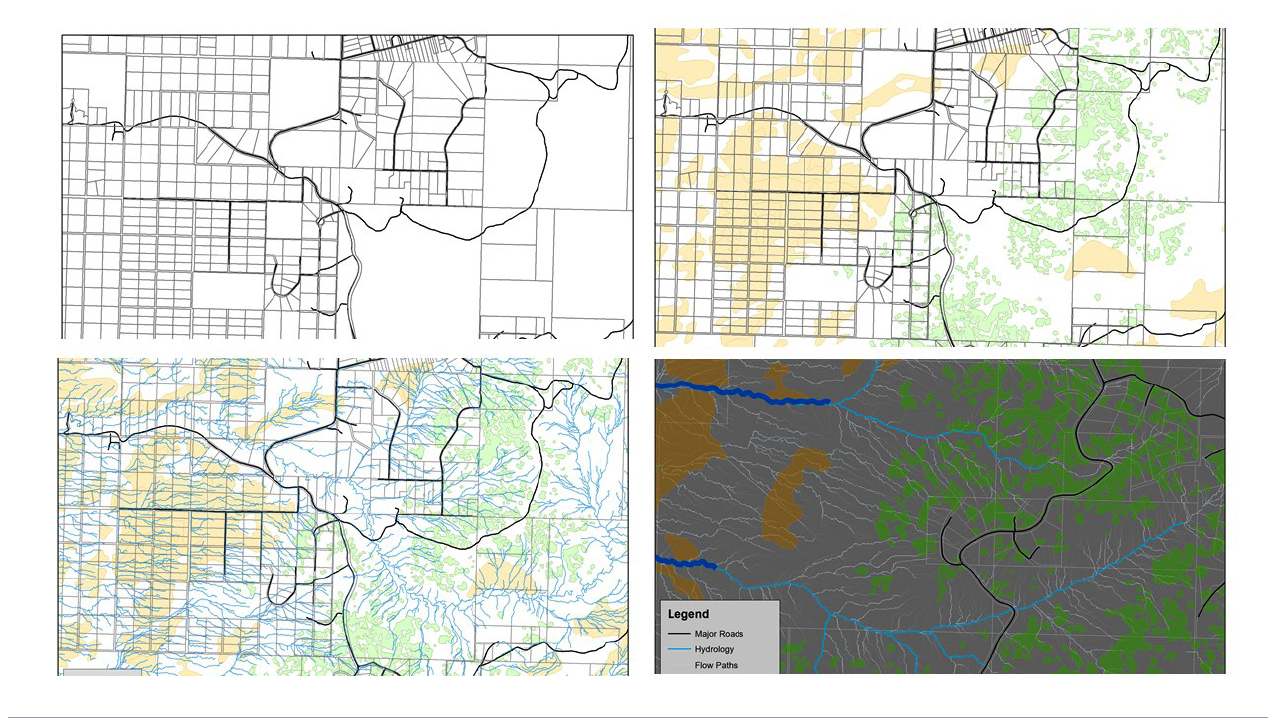
Fig. 4. Example maps from the spatial tool, which puts human activities such as ownership, roads, buildings, etc. in the context of landscape ecosystem support for salmon stream productivity, such as shallow groundwater flows, alder patches, and peatlands. The tool is used for case studies with regional stakeholders such as farmers interested in siting agricultural practices to avoid disruption of landscape support for salmon